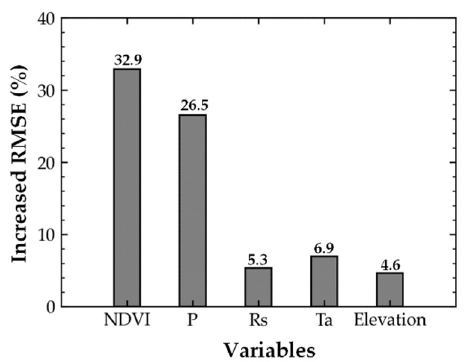
Figure 6. Importance of input variables to AGB upscaling model depicted by increased RMSE percentage, including NDVI, precipitation (P), downward shortwave radiation (Rs), air temperature (Ta), and elevation.